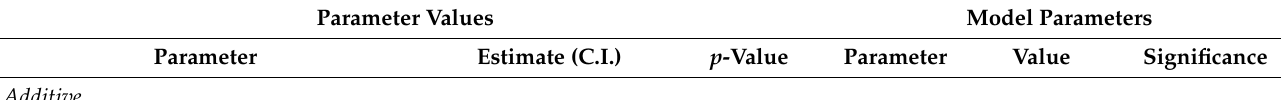
Table 1. Multivariate Geospatial Analysis for Central Nervous System Disorders. Parameter Values Model